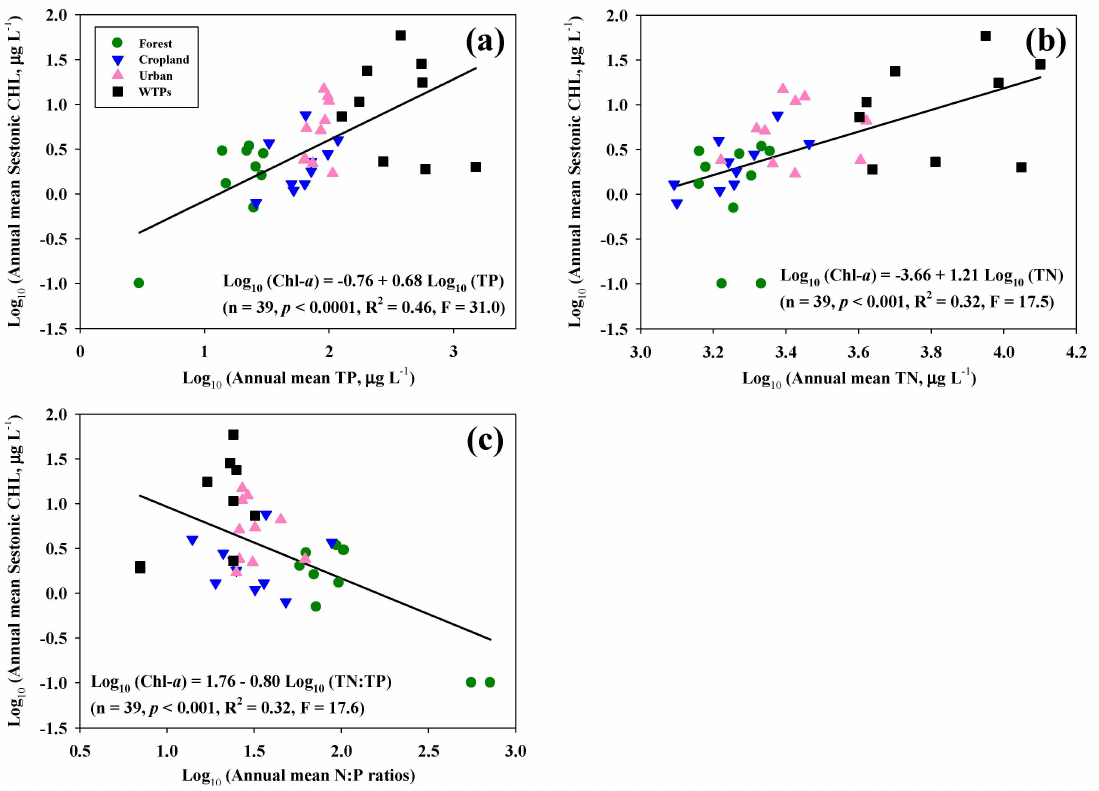
Figure 3. Simple linear regression models of log 10 -transformed annual mean ( a ) TP-sestonic CHL; ( b ) TN-sestonic CHL; and ( c ) N:P mass ratios-sestonic